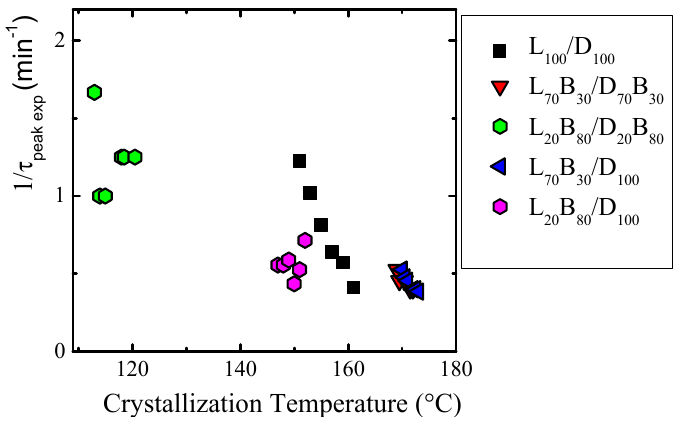
Figure 9. Overall crystallization rate (1/ τ peak exp ) versus crystallization temperature ( T c ) for PLA stereocomplexes.